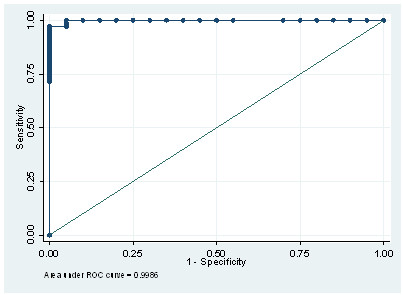
Receiver operating characteristics curve using percentage positivity measurements of serum pools containing assigned proportions of known positive serum samples.